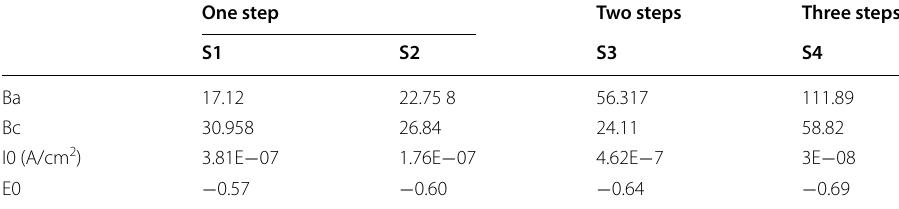
Table 4 Corrosion parameters of anodic oxidation films formed in the presence of various steps One step Two steps Three steps S1